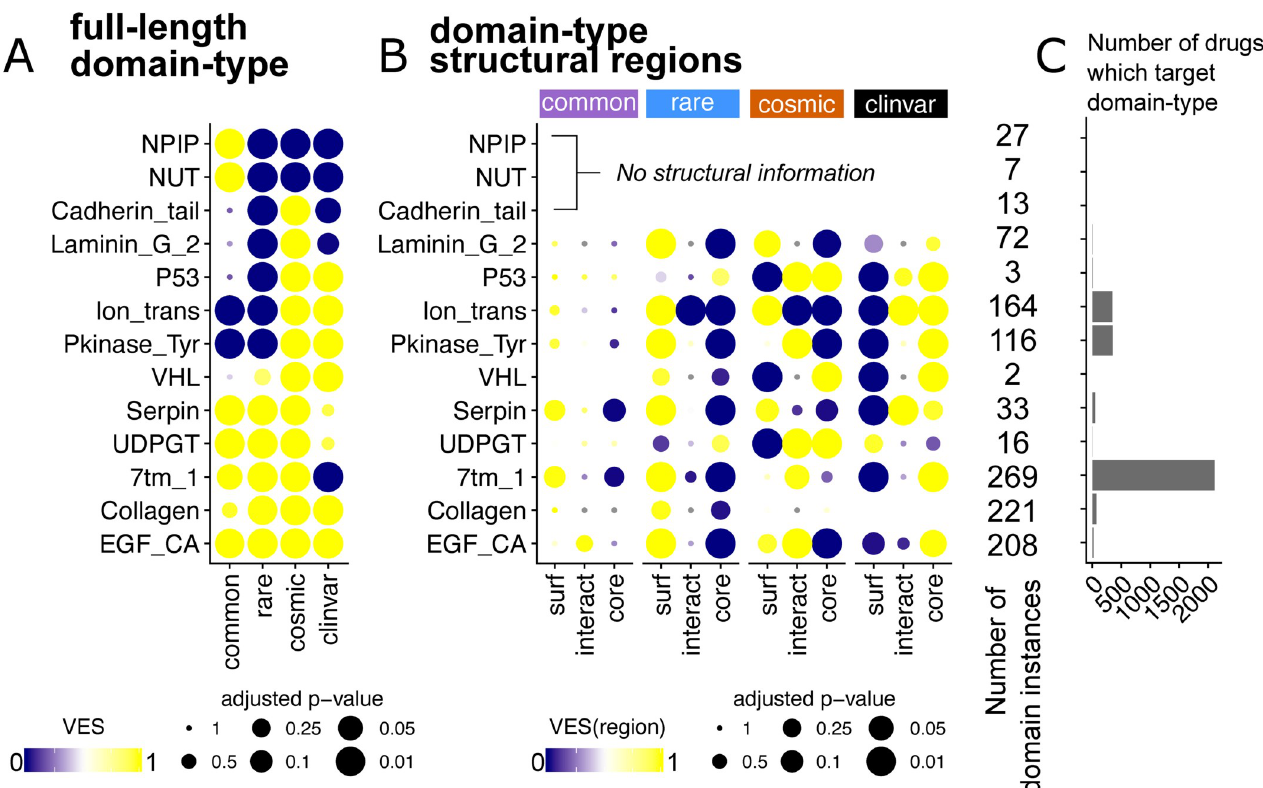
Fig 3. A domain-centric landscape of variant enrichment. Here, selected domain-types discussed in the main text are depicted. (A) VES at the full-length domain-type level. Bubble sizes are scaled by the adjusted p -value of the VES statistic. (B) VES calculated for each structural region (surface [ surf ], interacting interface [ interact ], and core) for the selected domain-types. (C) The number of drugs known to target proteins containing each domain-type is depicted as a bar graph. See S2 Data for the underlying data. NPIP, Nuclear pore complex interacting protein; NUT, Nuclear Testis protein; VES, Variant Enrichment